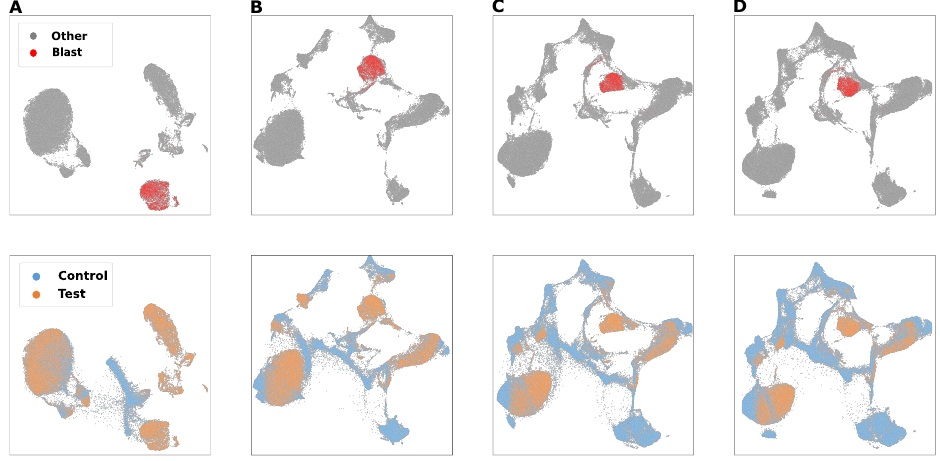
Figure A3. UMAP embedding of a test sample mixed with control-events for a fixed transform _ ratio = 1 but varying control _ ratio ∈ { 0,0.5, 1,1.5 } (columns A – D ). The first row shows the embedding learned with increasing number of control-events mixed to the test sample. Blasts are in red, non-blast events are grey. The second row shows the same respective UMAP representation with the test-events (orange) where additional control-events (blue) are transformed into the embed- ding space. For low value of control _ ratio blast events are well separated but additionally projected control-events are spread out between clusters (column A – B ). For higher values of control _ ratio blasts adhere to healthy cell populations, which makes it harder to detect them as separate cluster, but additionally projected control-events mix well with the clusters of healthy cell